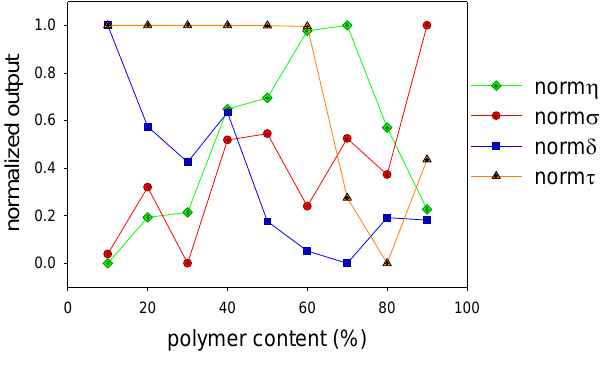
Figure 9. Normalized outputs of PC-PSPs related to the polymer content